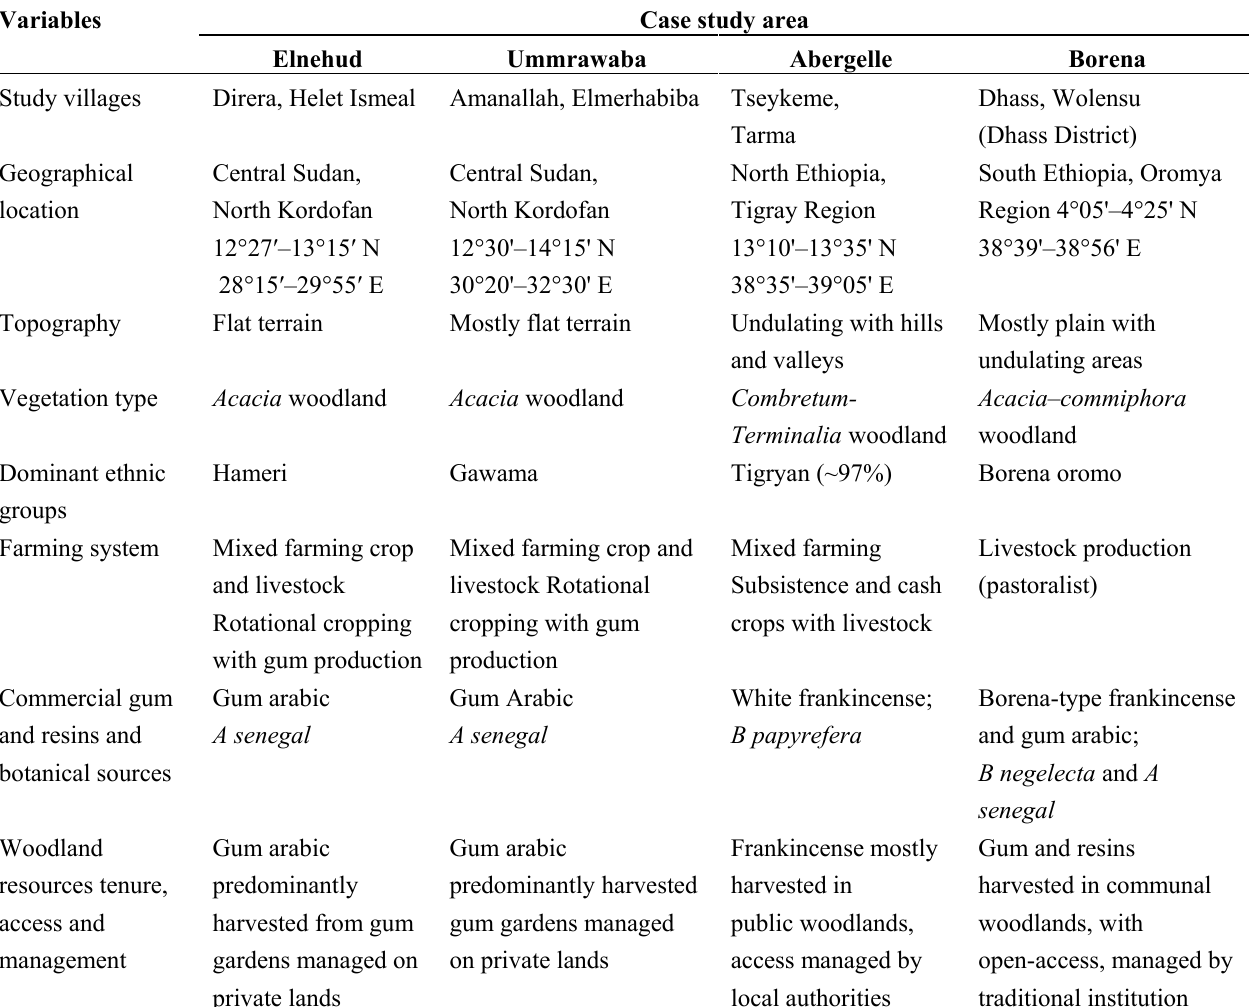
Table 1. Summary of the socioeconomic and biophysical characterstics of the study